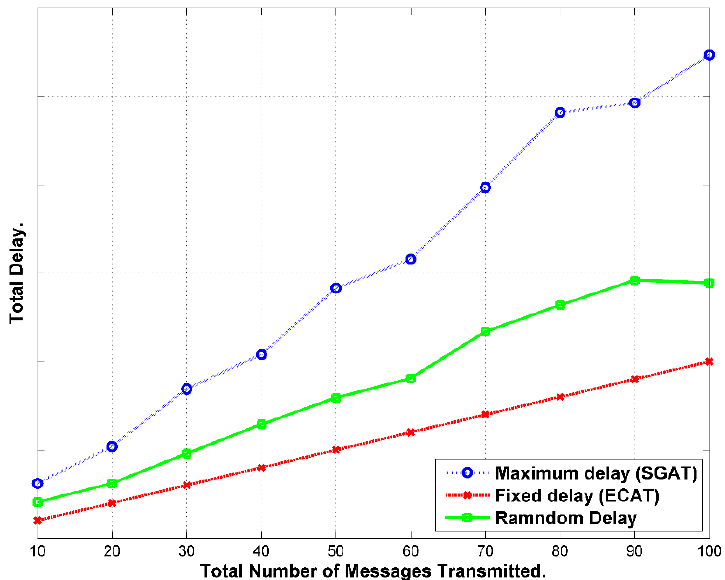
Figure 21. Total accumulated delay per one node increases as number of messages